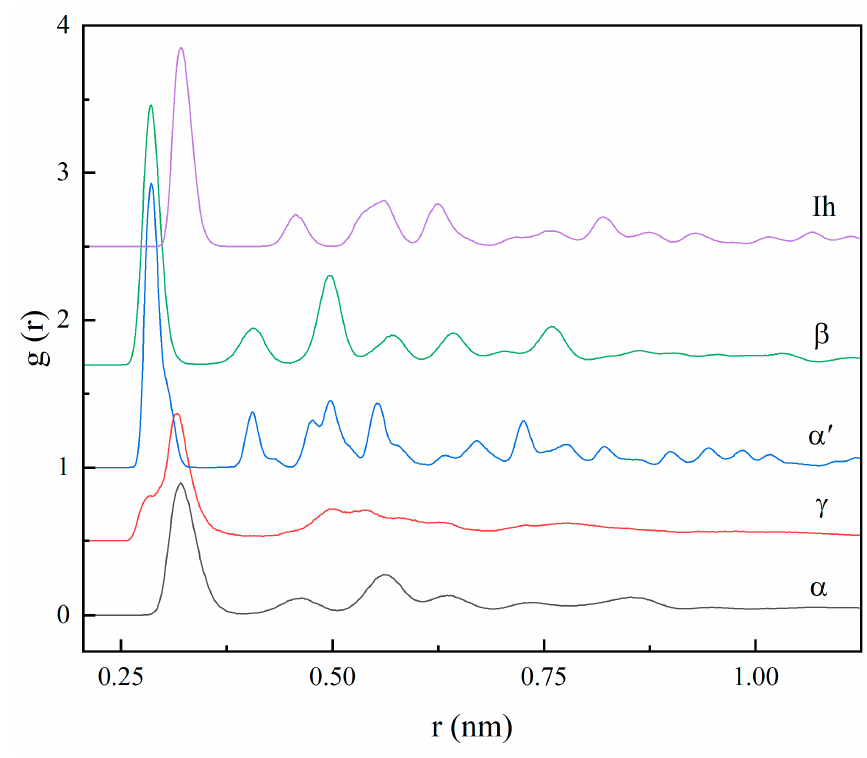
Figure 2. Pair-distribution functions (PDFs) of five packing structures.